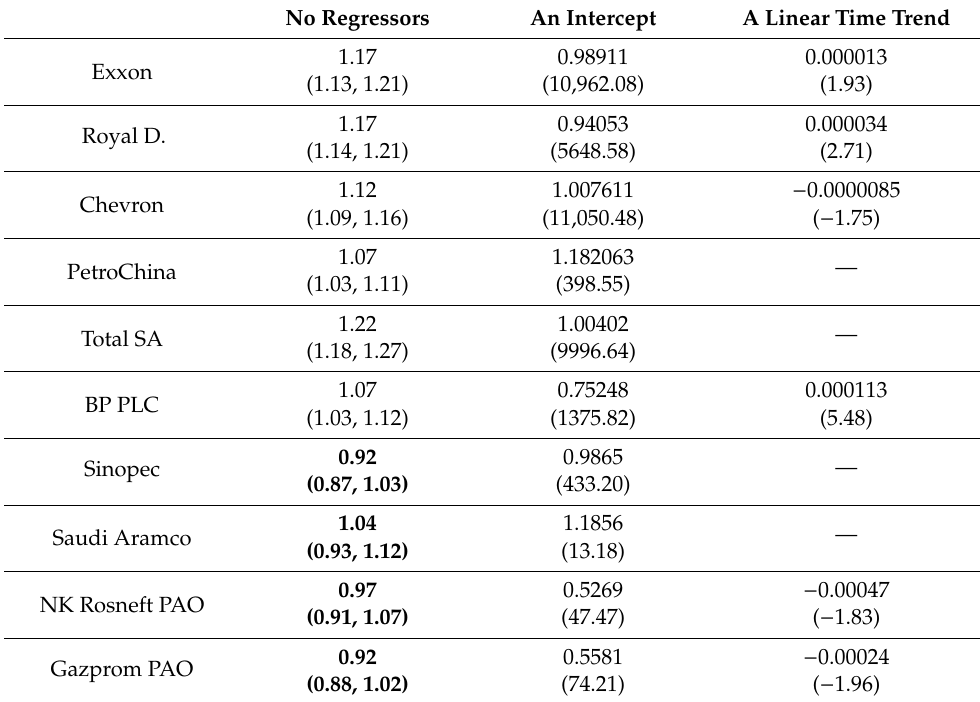
Table 5. Estimated coe ffi cients for the selected models in Table 4 with